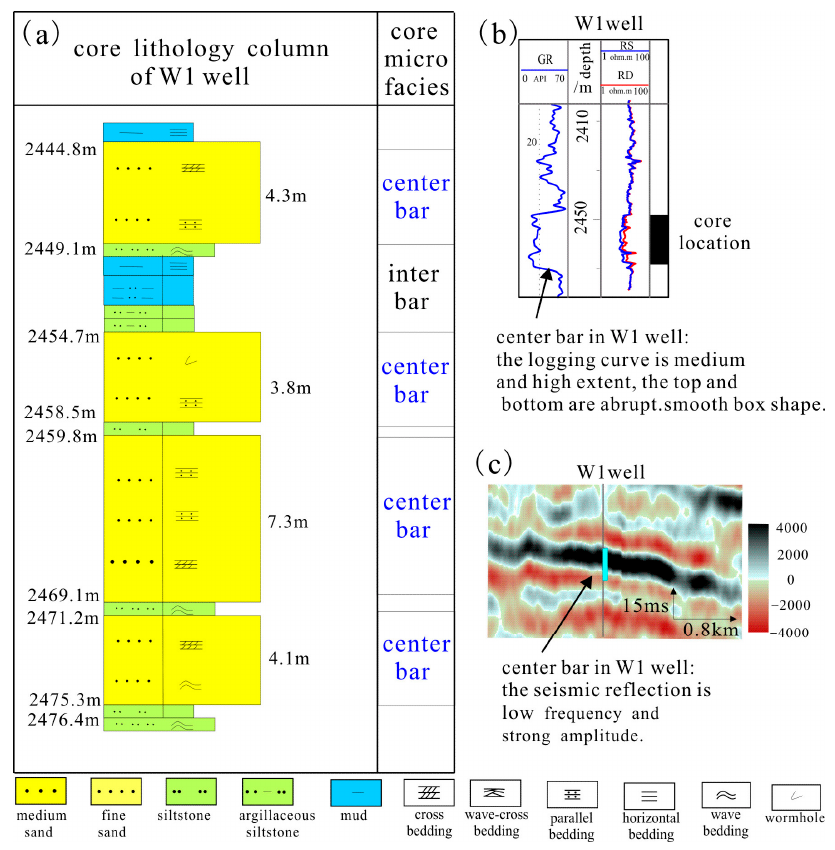
Figure 7. Core lithology column ( a ), logging motifs ( b ) and seismic reflection of center bar microfacies, W1 well ( c ).